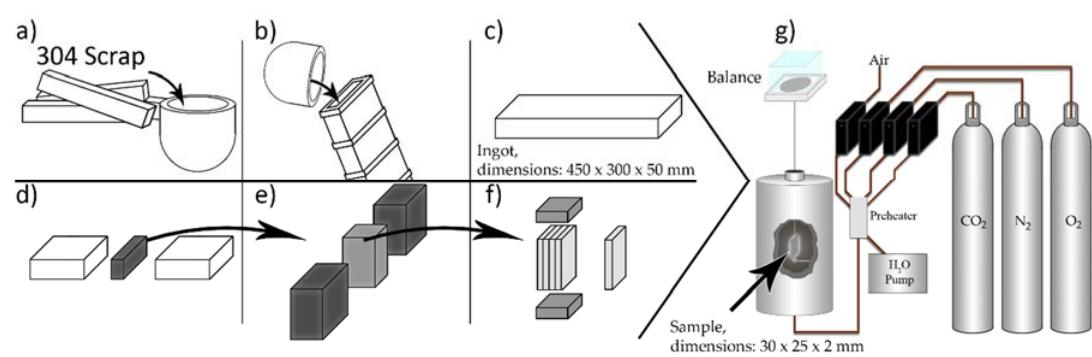
Figure 1. Sample preparation and test setup: ( a ) scrap pieces of AISI 304 slabs are melted in a vacuum induction furnace, ( b ) pouring the molten metal to a casting mould, ( c ) solidified laboratory slab, ( d ) cross sectioning of the slab, ( e ) further cross-sectioning from the middle of the slab, ( f ) slicing of the middle piece into test samples, ( g ) TG furnace setup with associated major components with an arrow pointing to the sample location in the furnace. Other major parts of the system are named, and the ingot and sample size are shown. Not to scale.